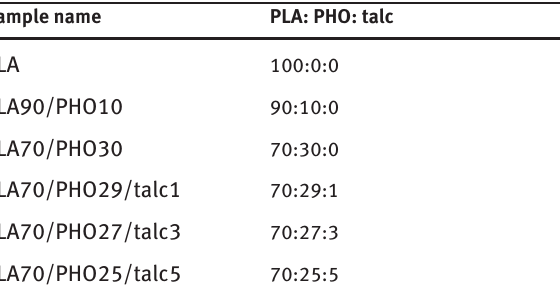
Table 1: PLA and its